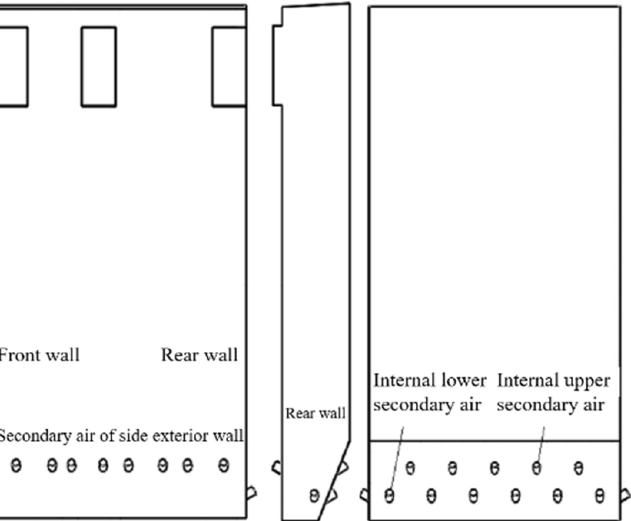
Figure 1. Structure of the part side of the 600 MW supercritical CFB boiler and the secondary air port layout.